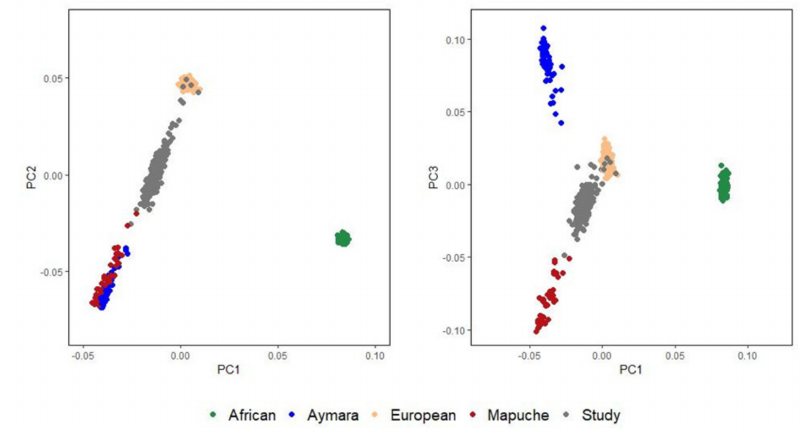
Figure 2. Genetic principal component analyses of study individuals and European, African, Mapuche, and Aymara reference